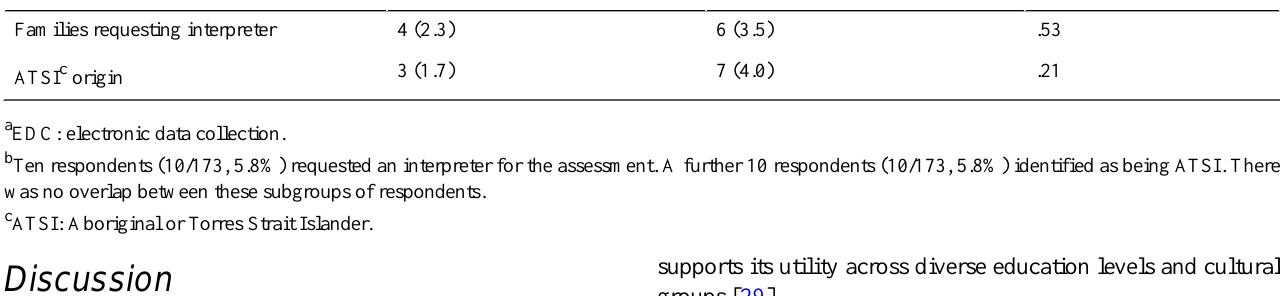
P valueOnline preference, n (%)Paper preference, n